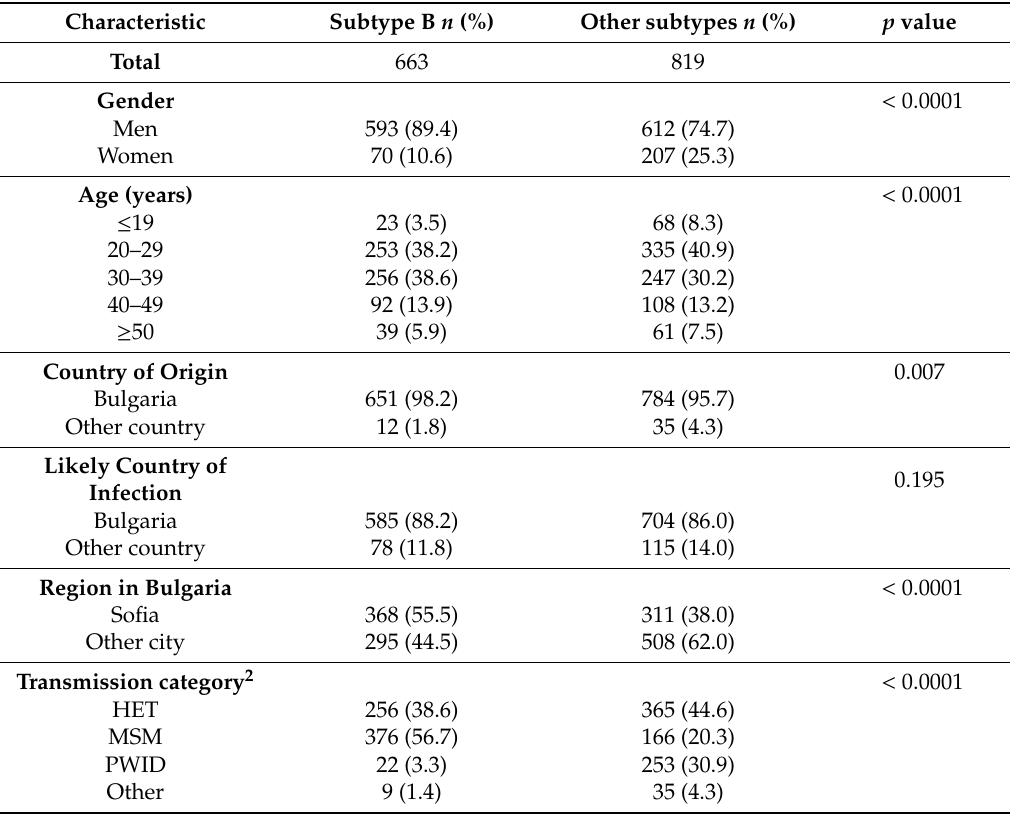
Table 1. Epidemiological characteristics of subtype B-infected study participants compared to infection with other subtypes in